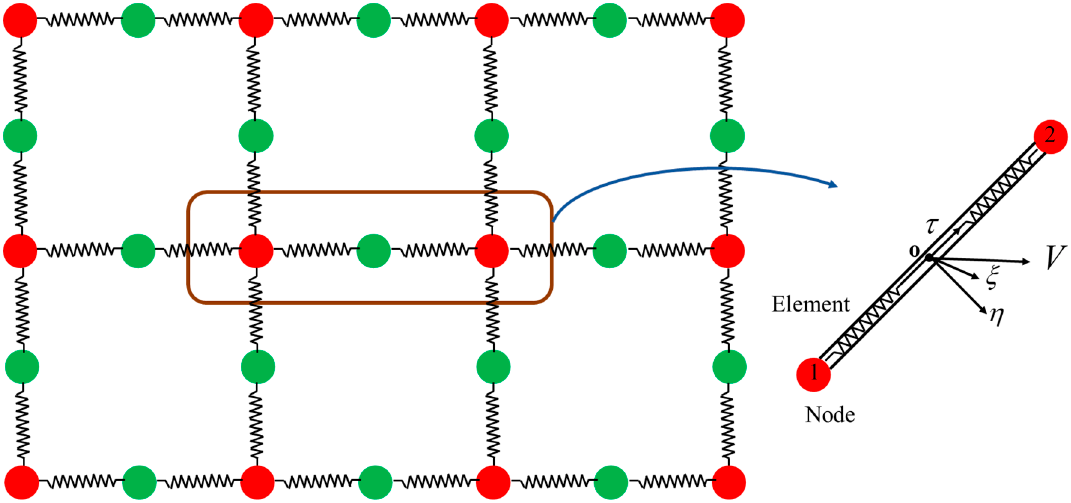
Figure 3. Mass-spring model for net.